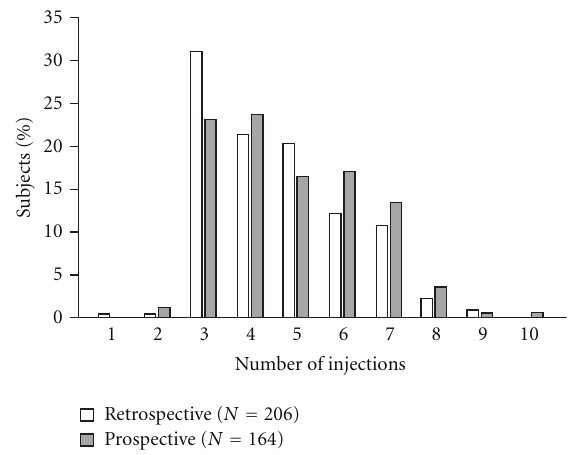
Figure 1: Number of ranibizumab injections received during year 1 in the retrospectively and prospectively recruited subpopulations (on-treatment population, n =